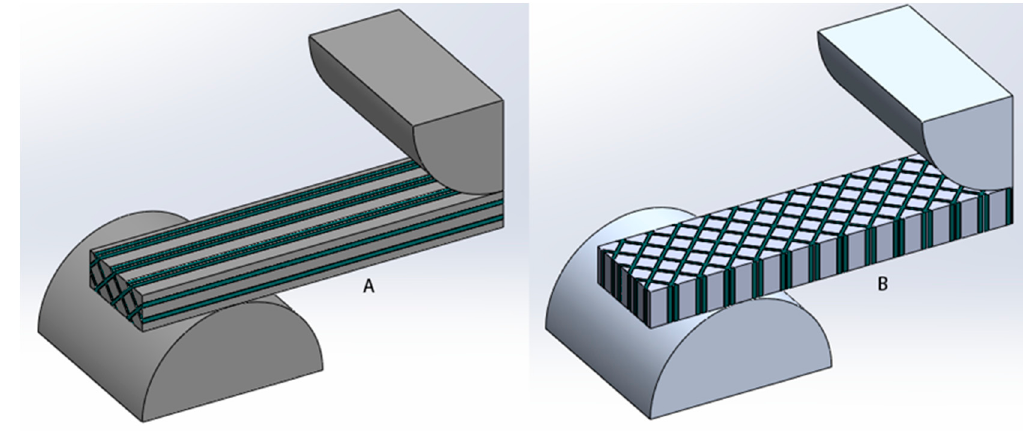
Figure 8. Layers and lines of vertical pixilation in a section of the edge sample. Resin: Castable Blend.